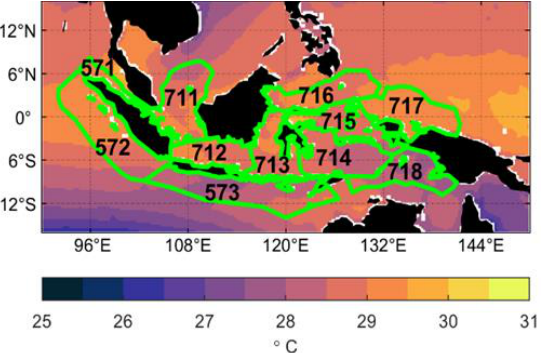
Figure 1. Research map and FMAs – bounding polygon superimposed with the annual mean of SST. Shape resource: [22].